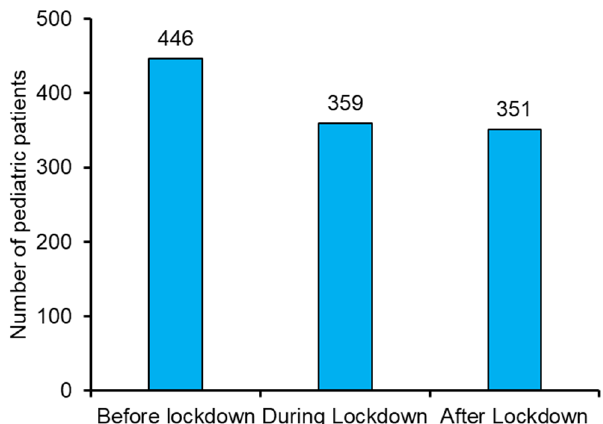
Figure 3. The number of pediatric patient visits in the dental clinics before, during, and after the lockdown.